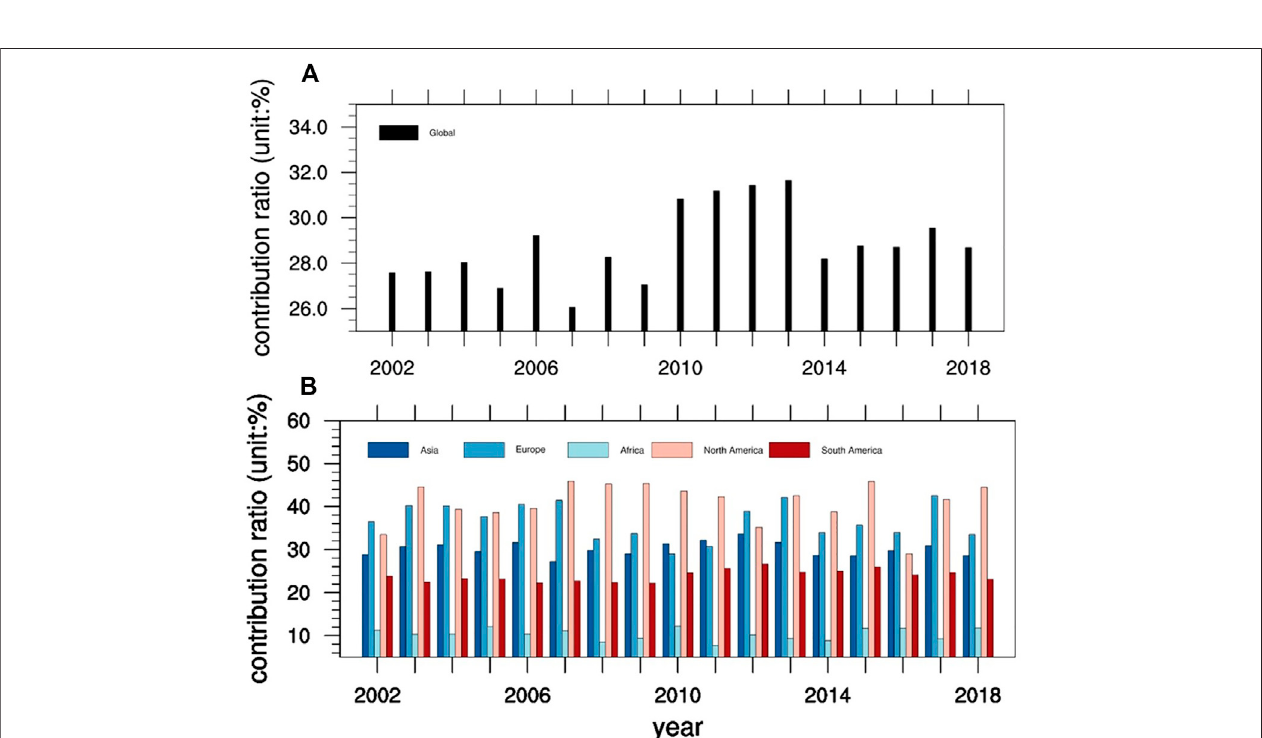
FIGURE 7 | The evolution of the AD contribution ratio at the global scale (A) and typical regions (B) from 2001 to 2018. Global (60 ° S~60 ° N, 180 ° W~180 ° E); Asia (1 – 60 ° N, 26 – 178 ° E); Europe (37 – 60 ° N, 9 ° W~0 ° – 5 ° E); Africa (35 ° S~37 ° N, 17 ° W~0 ° – 9 ° E); North America (7 – 60 ° N, 170 ° W~55 ° W); South America (53 ° S~7 ° N, 80 ° W~35 °